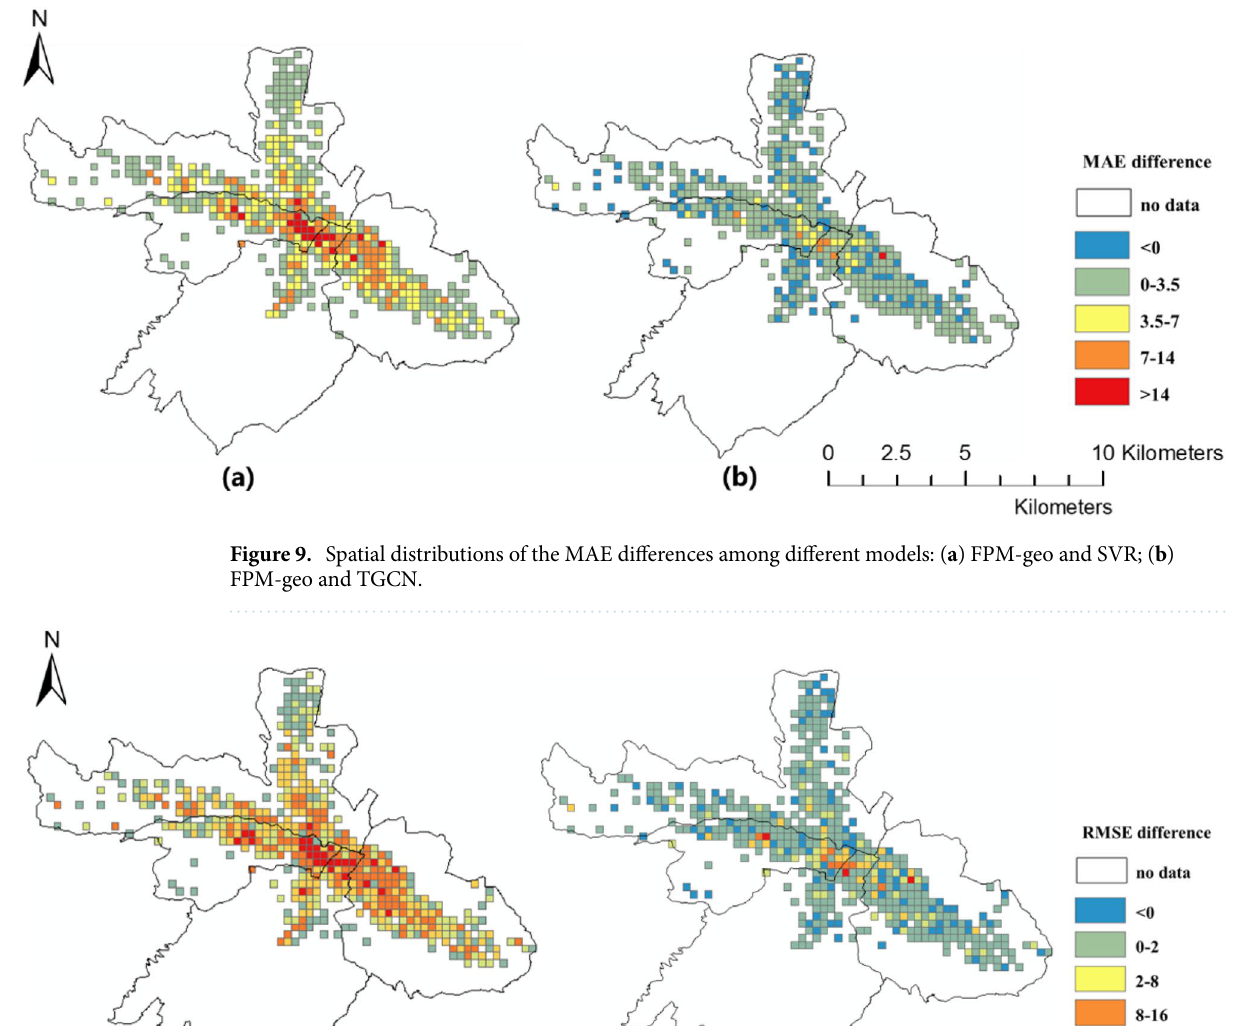
Figure 8. Spatial distributions of the MAPEs of different models: ( a ) SVR; ( b ) TGCN; ( c ) FPM-geo.